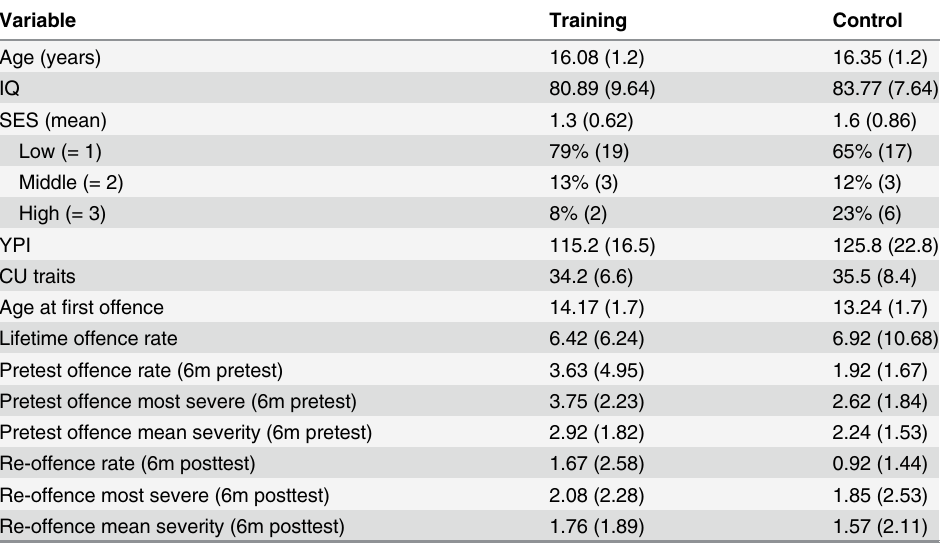
Table 1. Demographic characteristics and offending data of young